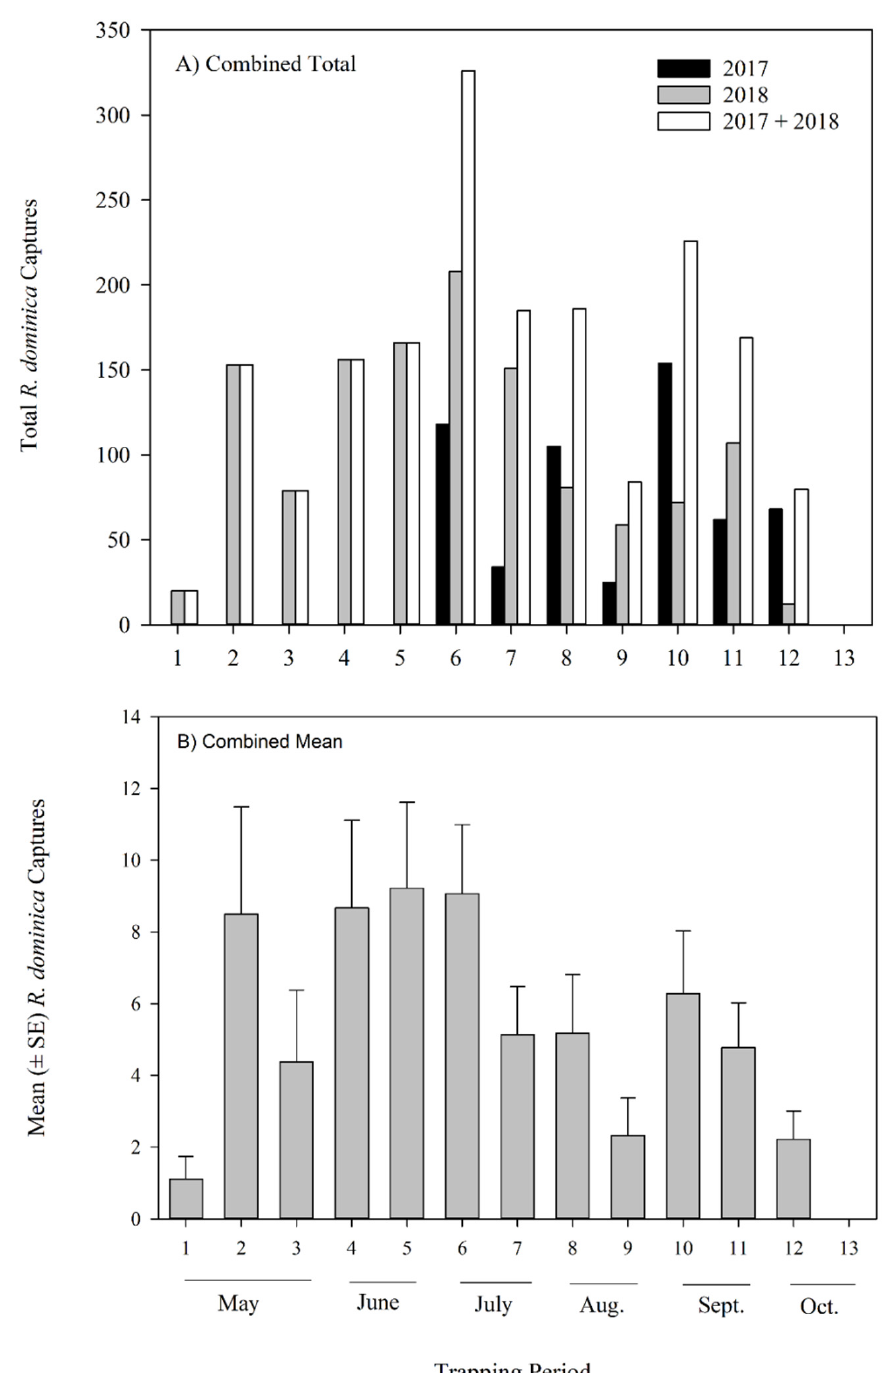
Figure 3. ( A ) Combined total Rhyzopertha dominica captures among all locations and attractant types for 2017 (black bars), 2018 (gray bars) and the combined 2017 + 2018 captures (white bars) for each trapping period; ( B ) Combined mean (±SE) R. dominica captures among all locations, attractant type, and year of study for each trapping period.